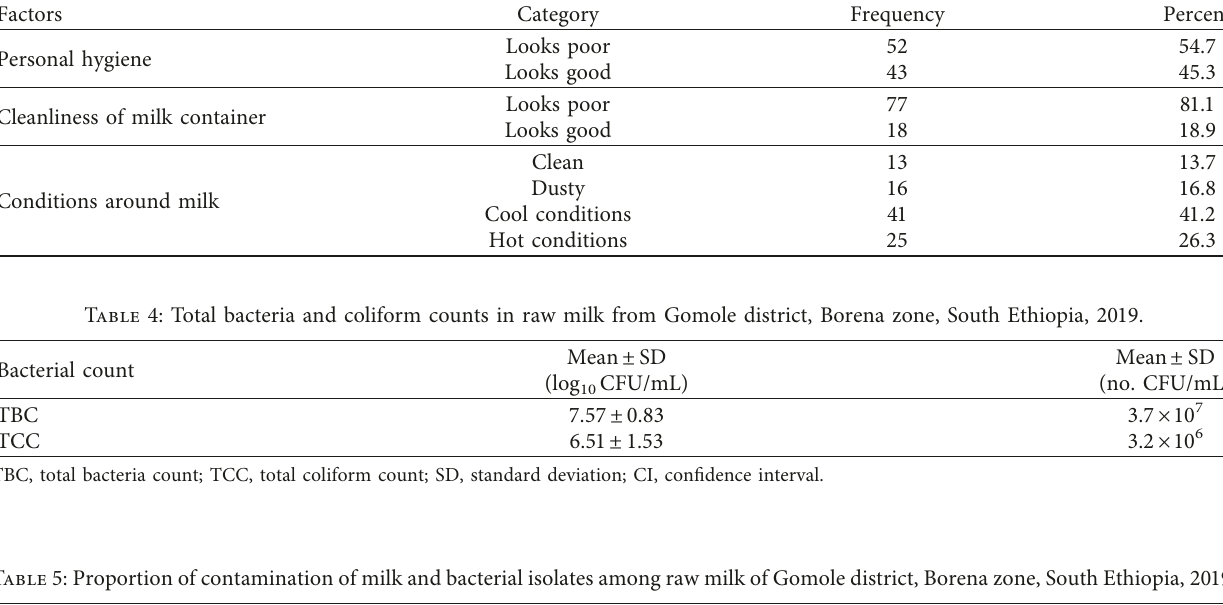
Table 5: Proportion of contamination of milk and bacterial isolates among raw milk of Gomole district, Borena zone, South Ethiopia, 2019. Bacteria isolates S . aureus — — Salmonella Spp. — — E . coli — TBC, total bacteria count; TCC, total coliform count.